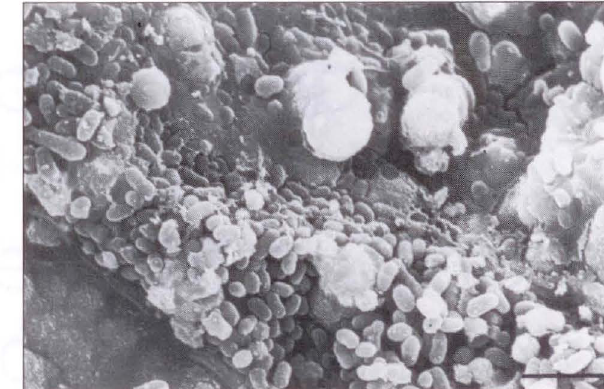
Figure 1) Scanning electron micrograph of the luminal swjace of a colonized catheter demonstrating the bacterial cells